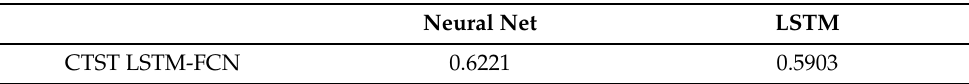
Table 4. Results of the classifier two-sample test. The closer to the chance level, the better are the results. Neural Net LSTM CTST LSTM-FCN